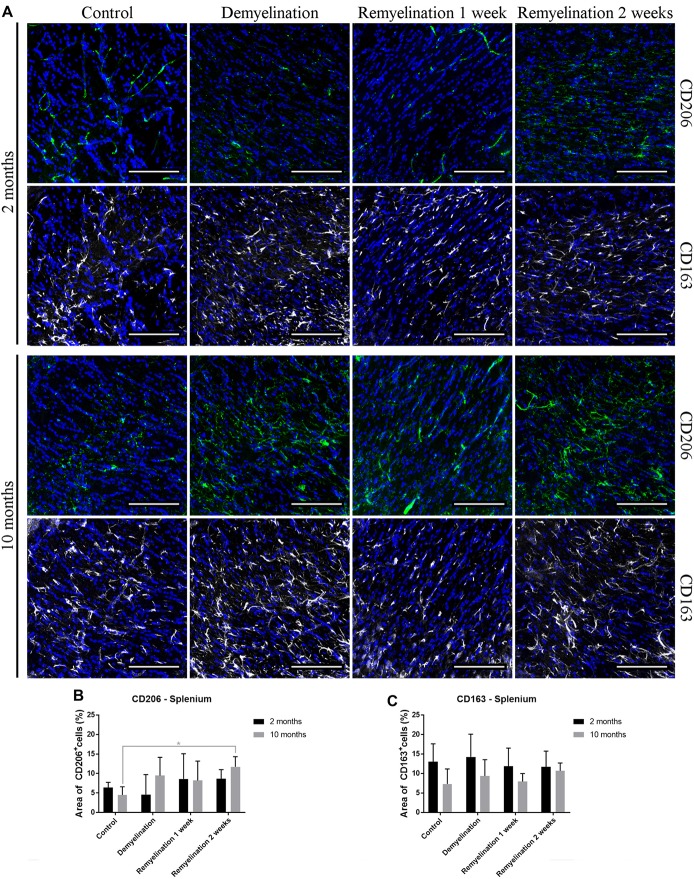
Increase of CD206 during remyelination in middle-aged mice in the splenium of the CC, while CD163 is unaffected. (A) CD206 (green) and CD163 (white) labeling. Cell nuclei are stained with DAPI (blue). (B) CD206 was significantly elevated in the middle-aged group after 2 weeks of remyelination. (C) CD163 was not significantly affected by age or treatment. Values are shown as means + SD (n = 6 per group). Statistical significance was evaluated using a two-way ANOVA followed by a Tukey’s post hoc test (C). The p-values are indicated in the graphs: treatment effects within the same age group: *p < 0.05. Bars: (A) 100 μm.